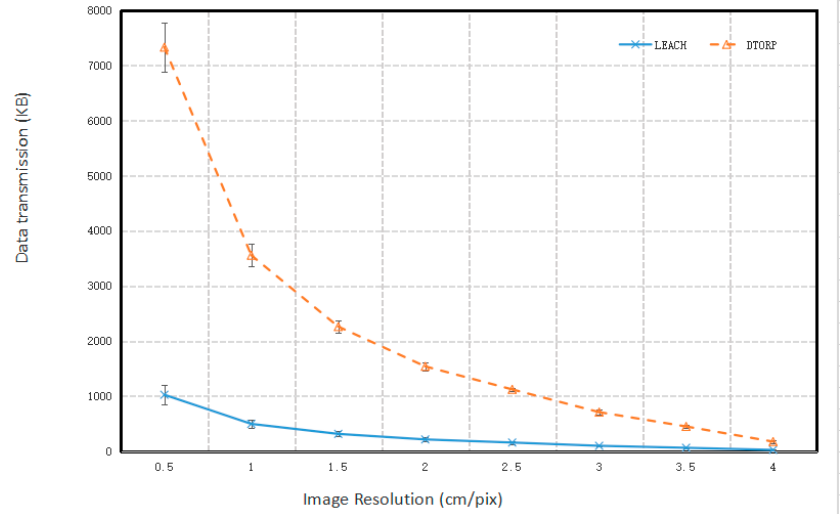
Figure 2. Total volume of data transmitted by the 10 sensor nodes in the wireless sensor network (WSN) clusters, with respect to the spatial image resolution of the unmanned aerial vehicle (UAV). LEACH: Low-energy adaptive clustering hierarchy. DTORP: Data transmission optimization routing protocol.